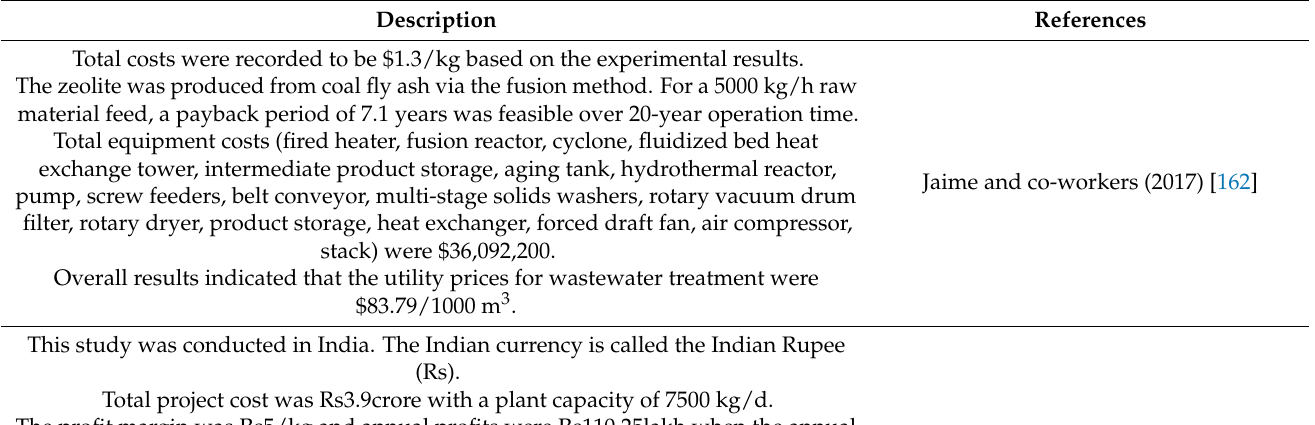
Table 12. The preparation costs and operation costs of zeolite.